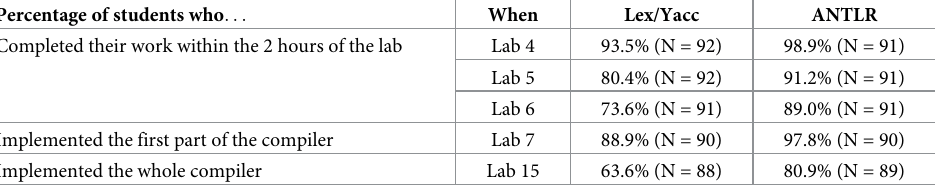
Table 5. Percentage of students who completed different activities related to lexer and parser implementation. Percentage of students who